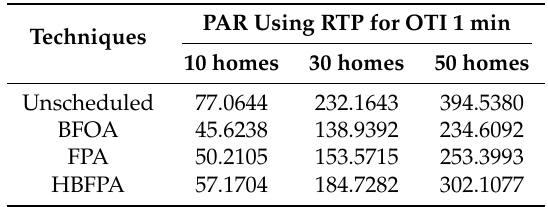
Table 17. Peak to average ratio for 24 h (for multiple homes).